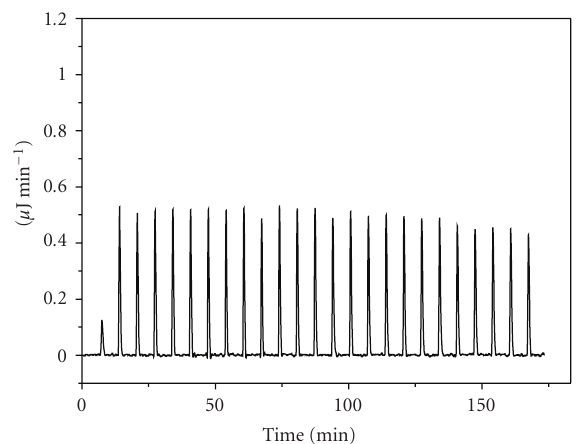
Figure 5: Raw ITC data for titration of d(CGCGAATTCGCG) 2 duplex with compound 1 . With each injection of ligand, constant heat release was observed due only to ligand dilution.